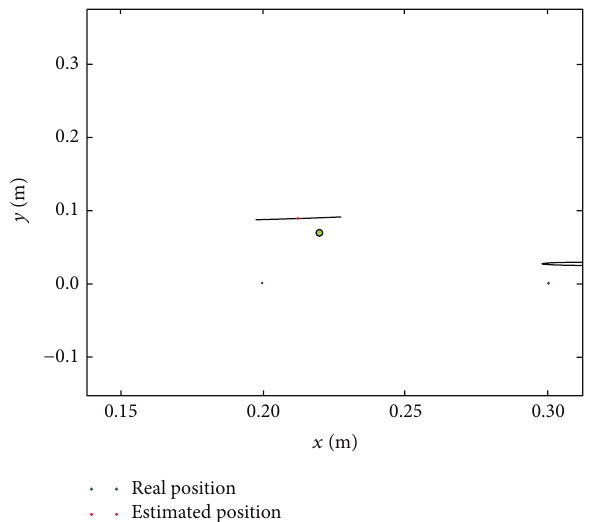
Figure 12: The enlargement result based on Figure 11 in order to see